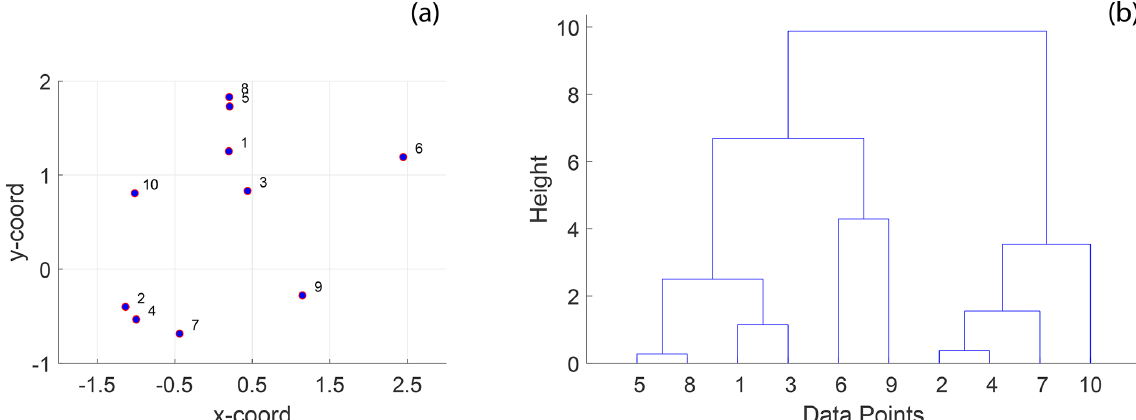
Figure 3. A simple example of hierarchical clustering using Euclidean distance: (a) 10 randomly positioned points in 2-D space and (b) a dendrogram computed from hierarchical clustering using the Euclidean distance depicting clusters of the 10 individual points at different levels organized into a hierarchy. The procedure of hierarchical clustering is shown in Algorithm 1.